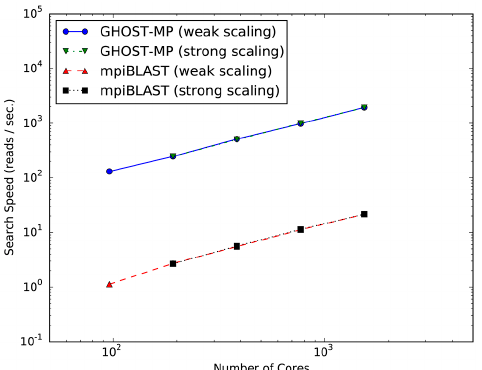
Figure 1. Scalability of GHOST-MP (Genome-wide HOmology Search Tool on Massively Parallel system) and mpiBLAST on TSUBAME 2.5. Strong scaling and weak scaling were measured using 96–1536 CPU cores. In the strong scaling setting at 96 CPU cores, the search speed could not be measured due to computational resource limitations.